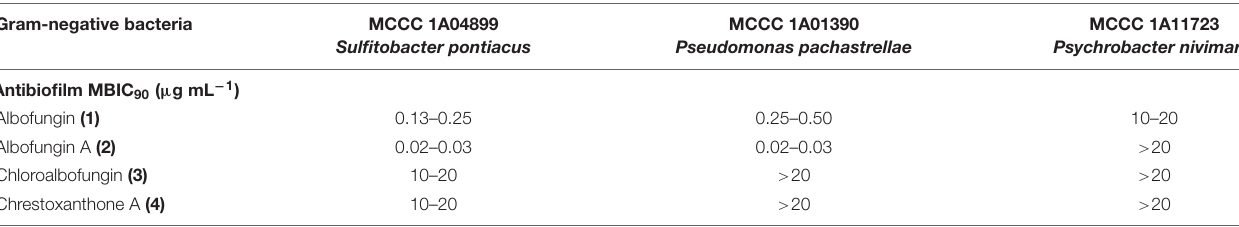
TABLE 3 | Biofilm inhibition assay of albofungins ( 1 – 4 ) against gram-negative marine